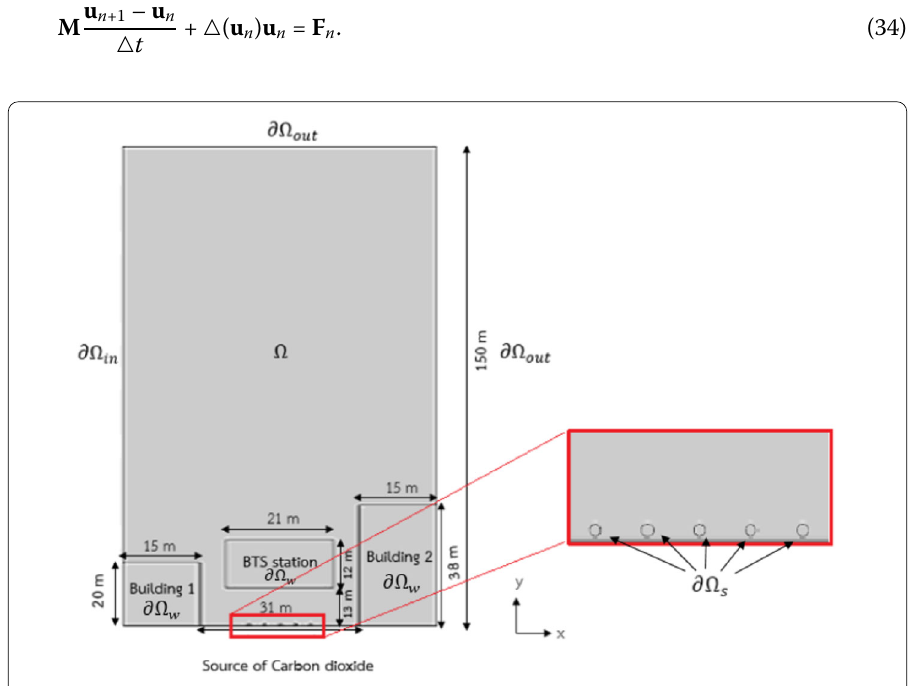
Figure 1 Computational